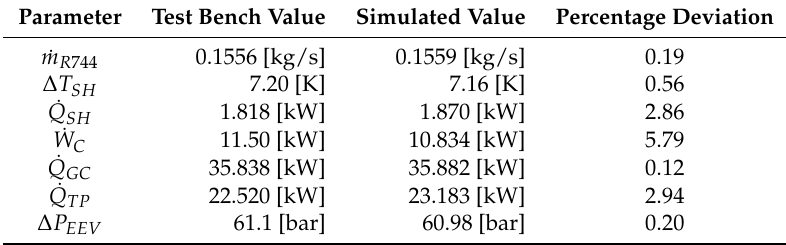
Table 3. Key cycle parameters at the 30% EV orifice opening cycle operating